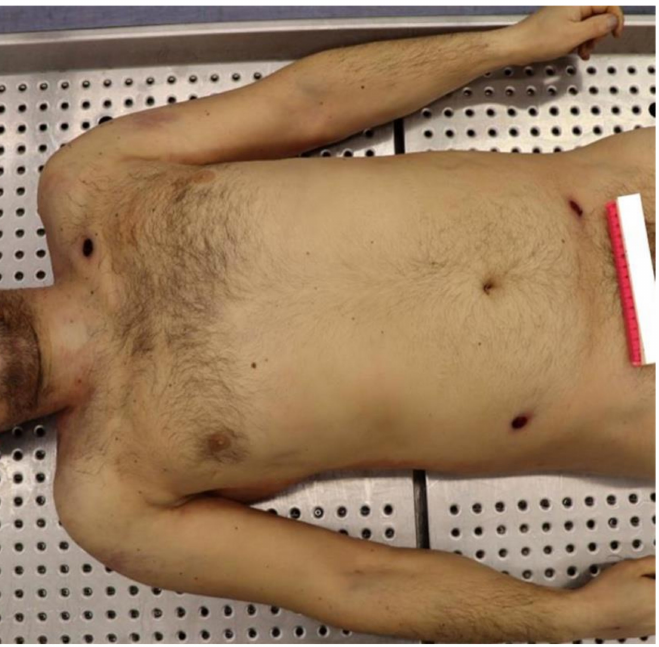
Figure 1. The corpse on the autoptic table at the moment of the external examination. The inlet and outlet ports of the perforating GSW are clearly visible, and so does the inlet port of the retained